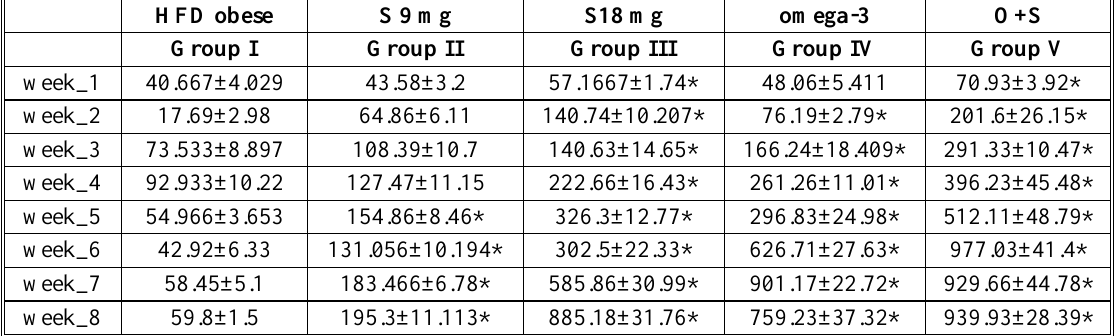
Table 1. Effects of two-different doses of simvastatin, omega-3, and combination of simvastatin and omega3 on the UCP1 gene expression level in brown adipose tissue (BAT)